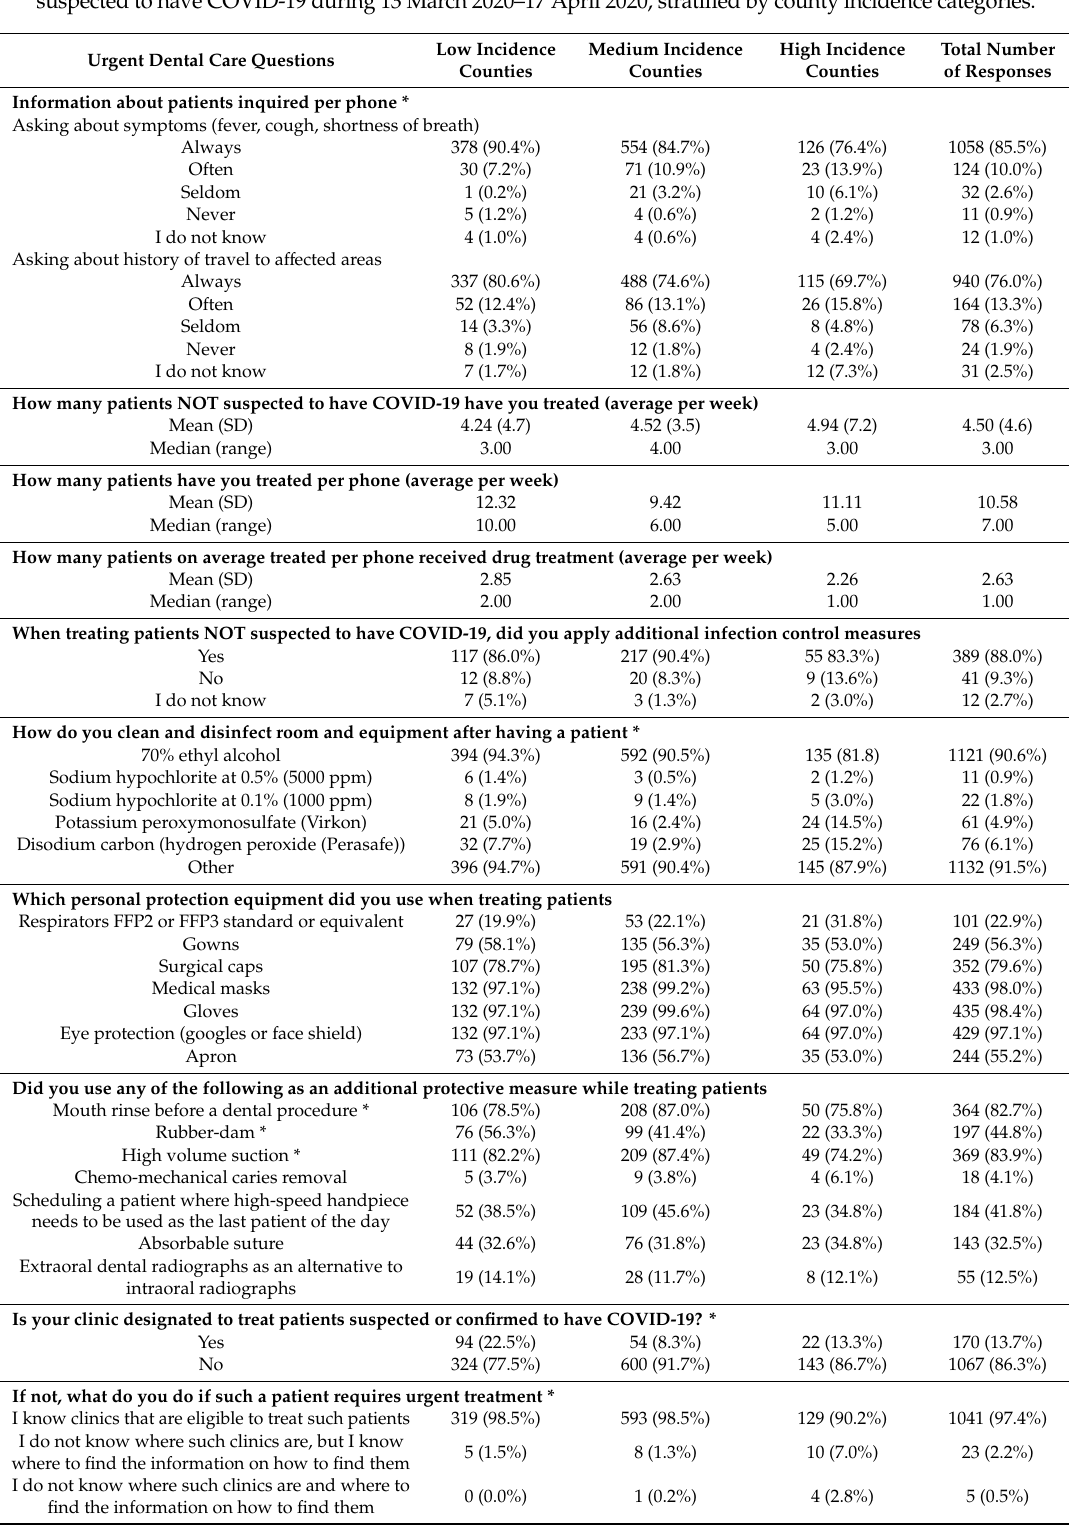
Table 2. Organization of urgent dental care in dental health service and management of patients